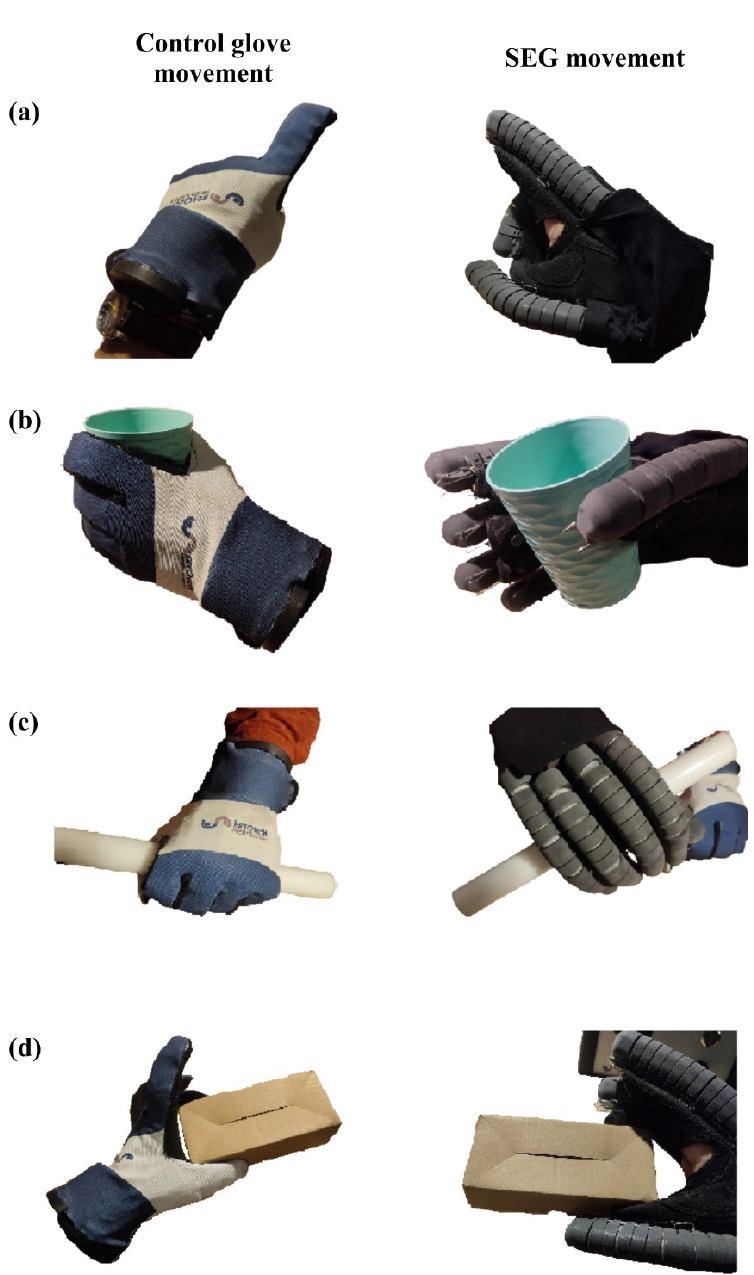
Figure 9. Indicative images of hand movements with the SEG and control glove. ( a ) Finger exercises; Holding exercises of ( b ) cup; ( c ) pipe; ( d ) box.